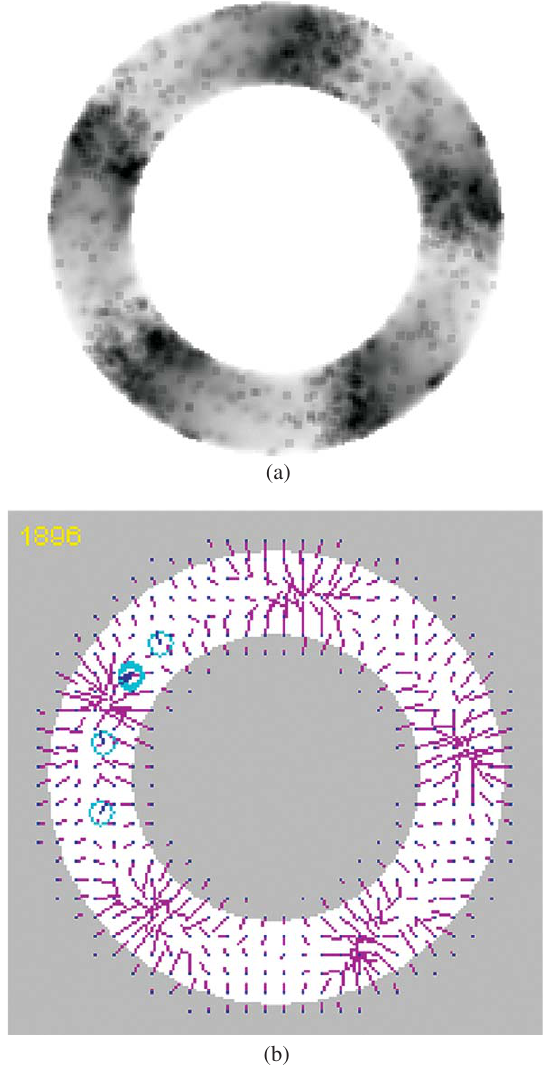
flux at extreme borders of each region. The difference